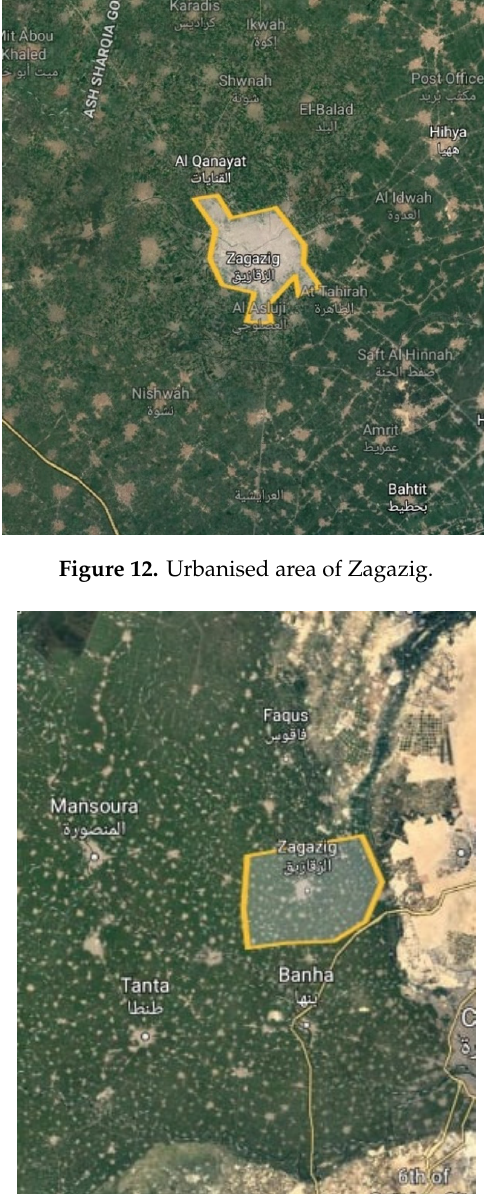
Figure 13. Total area of Zagazig .